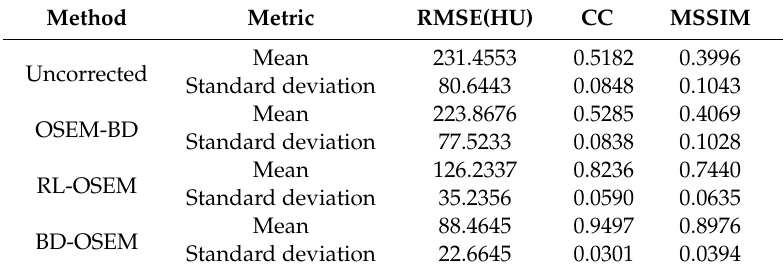
Figure 8. Comparison of the selected slice of reconstructed images for patient scan: ( a ) Reconstructed image without motion correction; ( b ) image reconstructed by OSEM-BD; ( c ) image reconstructed by RL-OSEM; ( d ) image reconstructed by the proposed method; ( e ) repeated scan. Table 4. Evaluation of motion artifact reduction performance on patient scan.